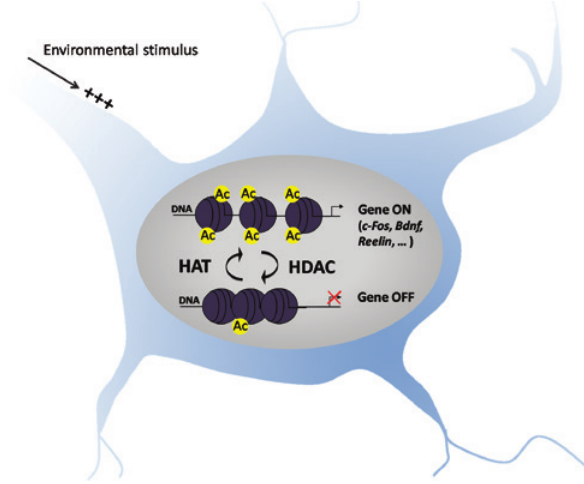
Figure 1: Regulation of histone acetylation in neurons in response to an environmental